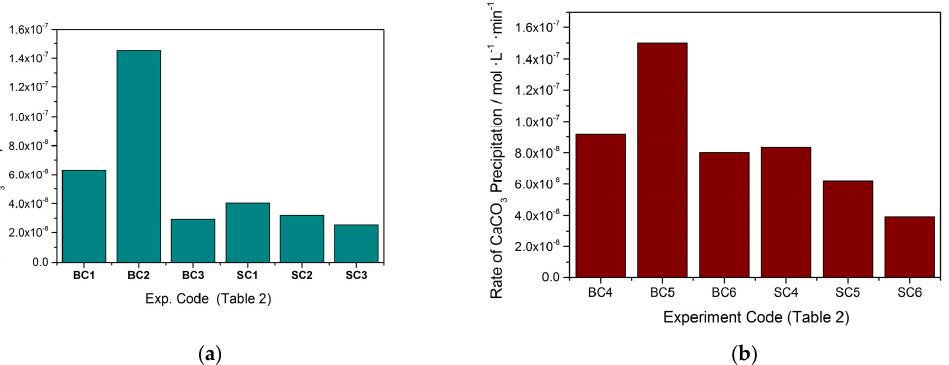
Figure 5. Calcium carbonate precipitation rates in the presence of A. obliquus culture and nutrient medium under illumination in the presence of zinc. ( a ) Ca t = C t = 1.7 mM; ( b ) Ca t = C t = 3.4 mM; 25 °C, pH initial 8.50, 0.15 Μ of NaCl; BC1: No solid (reference); BC2: 10 mL of metabolically active culture A. obliquus ; BC3: 5.6 μ M of Zn, No solid; SC1: 5.6 μ M of Zn and 10 mL of metabolically active culture A. obliquus ; 11.0 μ M of Zn and 10 mL of metabolically active culture A. obliquus ; 15.0 μ M of Zn and 10 mL of metabolically active culture A. obliquus .